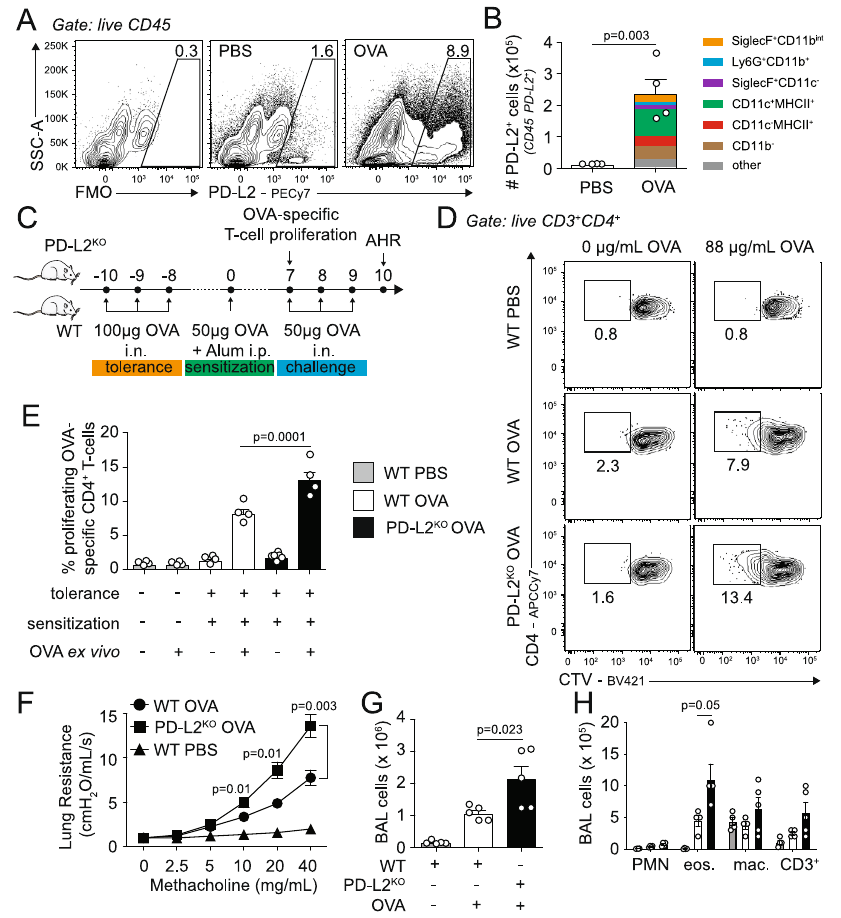
Fig. 1 | PD-L2 de fi ciency prevents the induction of respiratory